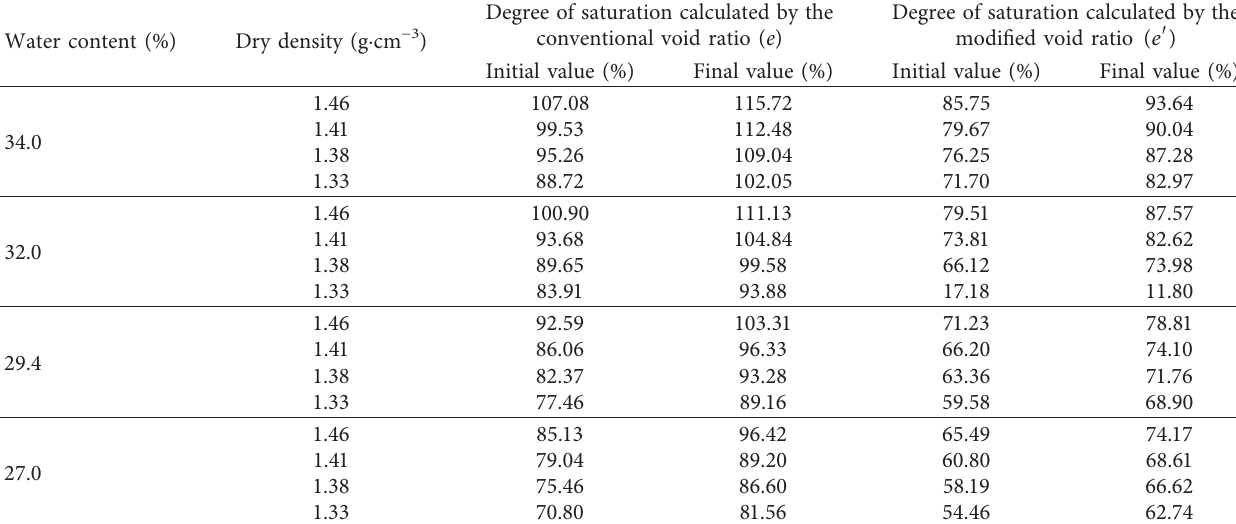
Table 6: Degree of saturation of the MH soil before and after the consolidation